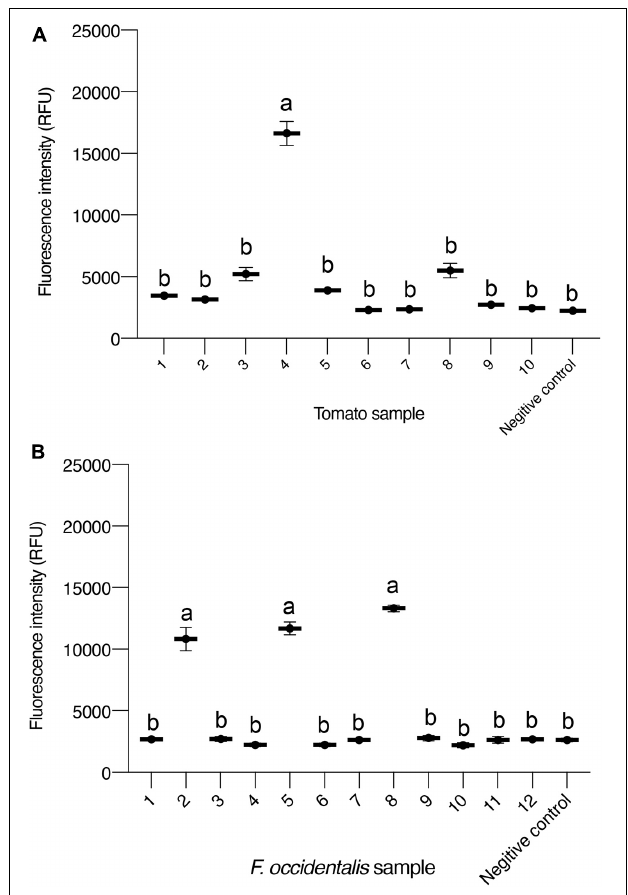
FIGURE 5 | Detection of samples using CRISPR/Cas13a-based detection in plants and Frankliniella occidentalis . (A) Intensity of fluorescence signals generated after 15 min (30 kinetics cycles) of the CRISPR/Cas13a-based detection of 10 tomato samples. The negative control has healthy tomato as input. (B) Intensity of fluorescence signals generated after 15 min (30 kinetics cycles) of CRISPR/Cas13a-based detection of 12 F. occidentalis samples. Data are the mean ± SD. from triplicate biological replicates measurements. Negative control has healthy F. occidentalis as an input. Comparisons between groups were made using an analysis of variance (ANOVA) followed by a Tukey’s test. Different letters above the error bars indicate significant differences at the 0.05